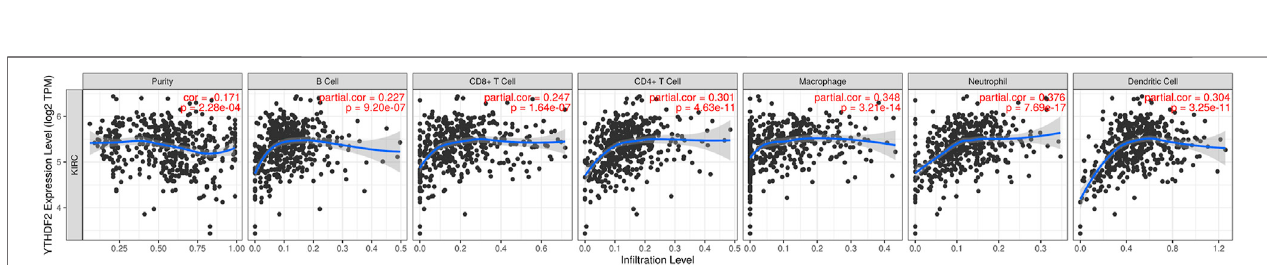
FIGURE 5 | The expression of YTHDF2 was shown to be signi fi cantly linked to immune cell in fi ltration.